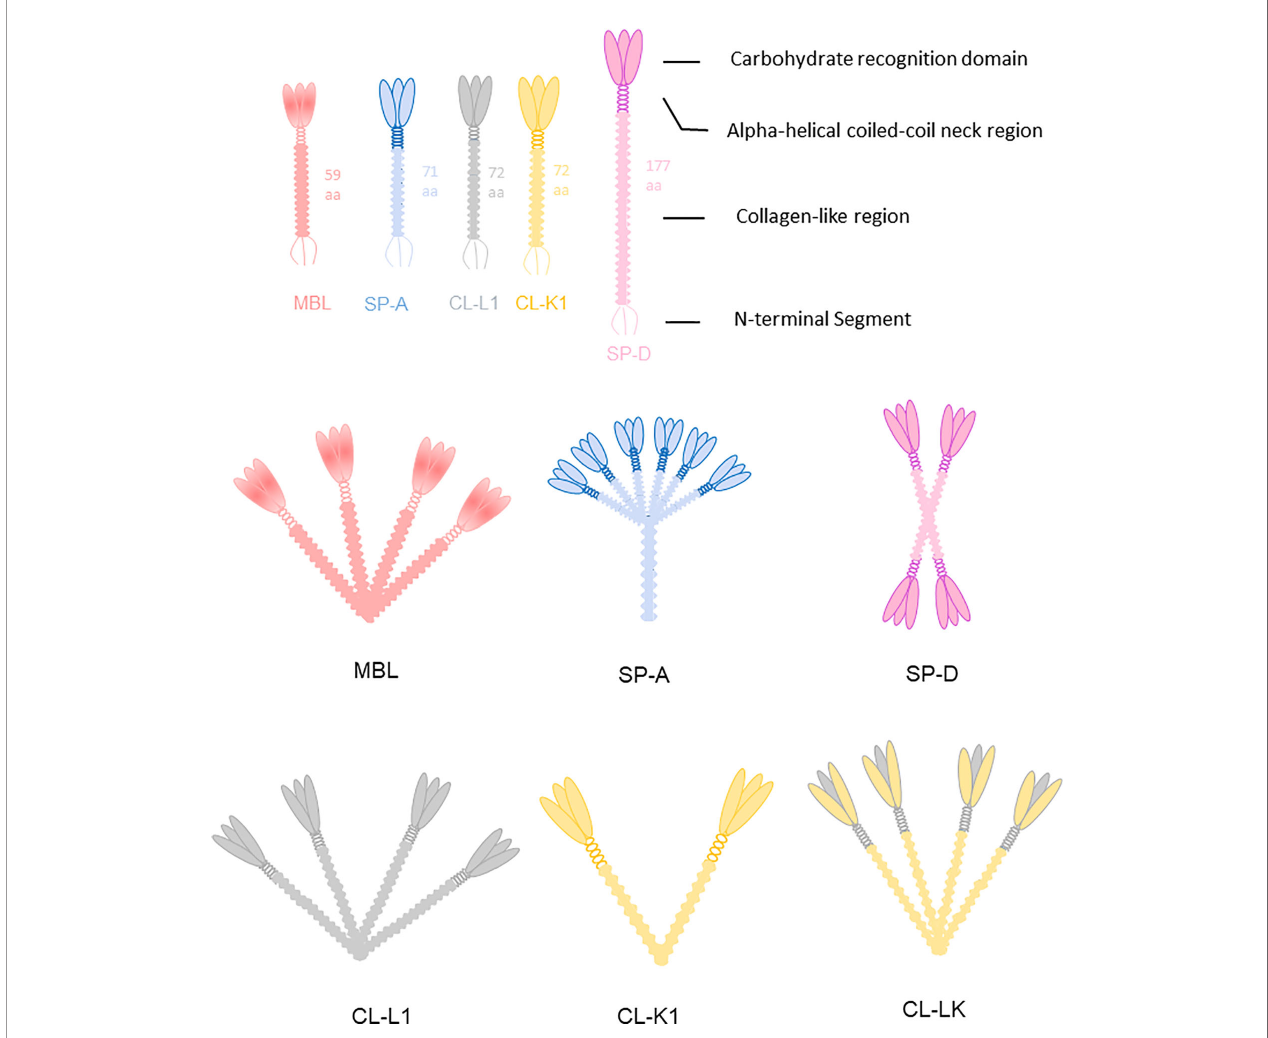
FIGURE 3 | Collectins are constructed of four domains: an N-terminal cysteine-rich segment, a collagen-like region, a neck region and a C terminal carbohydrate recognition domain (CRD). MBL usually forms trimers to hexamers. CL-K1 forms dimers and trimers of trimeric subunits. SP-A and SP-D are mainly hexamers and cruciform tetramers. The subunit of CL-LK are formed by two CL-K1 and one CL-L1